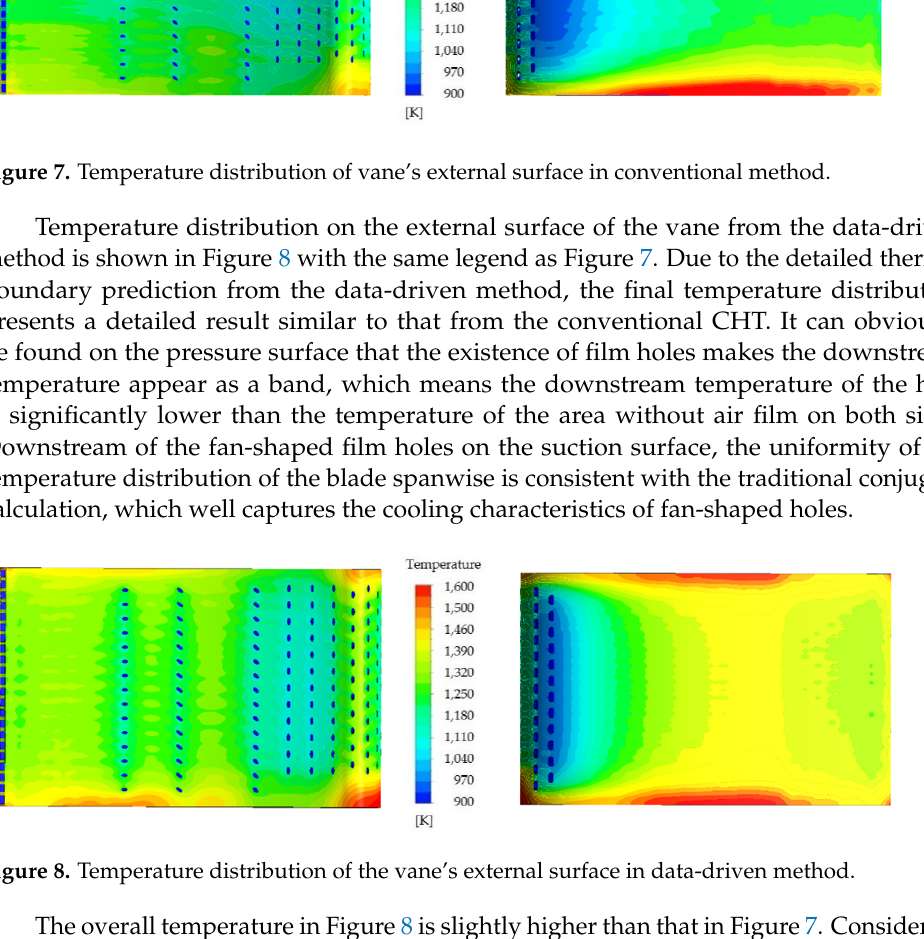
Figure 7. Temperature distribution of vane’s external surface in conventional method.